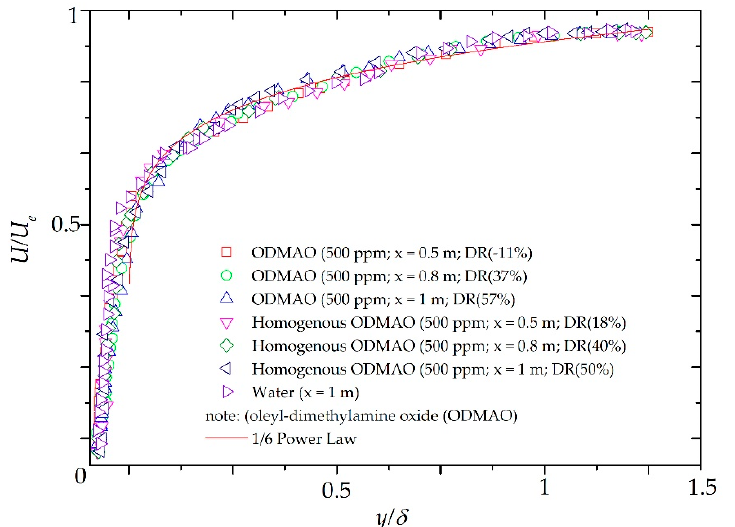
Figure 7. The comparison between homogenous and non-homogenous surfactant injection was affecting the drag reduction property.